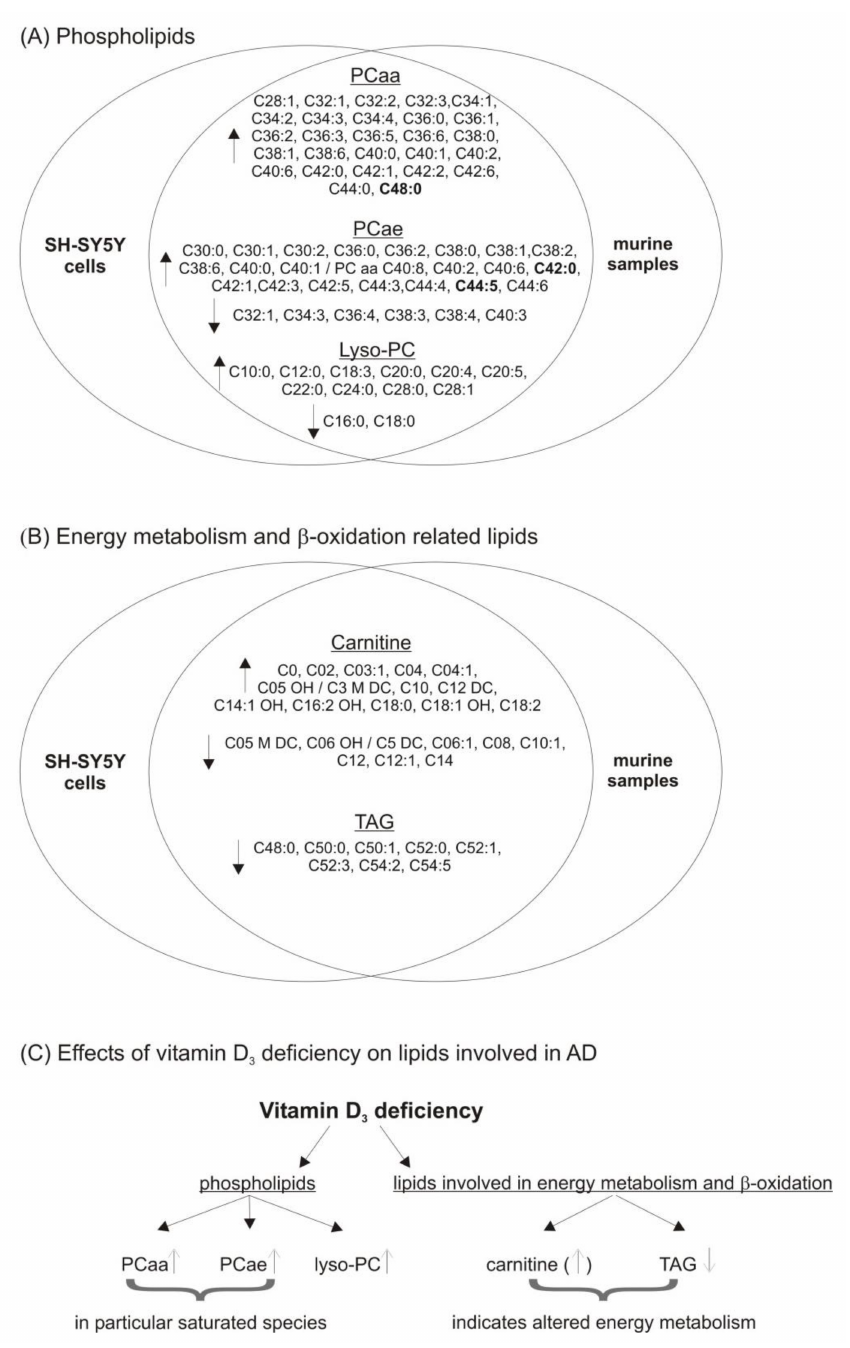
Figure 7. Overview of the effects of vitamin D 3 hypovitaminosis on lipid metabolism in neurob- lastoma cells and brain samples of mice with mild to moderate vitamin D deficiency. ( A ) Effects observed influencing the metabolism of phospholipids (phosphatidylcholine, PCaa; phosphatidyl- choline plasmalogens, PCae; lyso-phosphatidylcholine, lyso-PC) in a Venn diagram. ( B ) The effect of vitamin D3 deficit on lipids involved in cellular energy metabolism and β -oxidation (carnitine and triacyl glycerides, TAG) in a Venn diagram. ( C ) Summary of the influence of vitamin D 3 deficit on different lipid classes known to be affected in disorders such as neurodegenerative Alzheimer’s disease